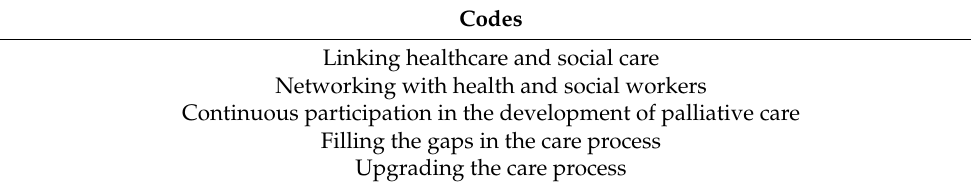
Table 2. Codes within a theme. The position of volunteers in the palliative care